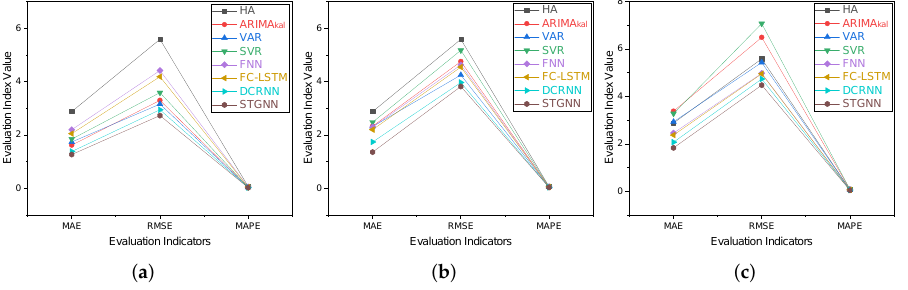
Figure 7. Performance comparison of models over different time periods on the PEMS-BAY datasets. ( a ) Performance comparison of models in 15 min time period. ( b ) Performance comparison of models in 30 min time period. ( c ) Performance comparison of models in 60 min time